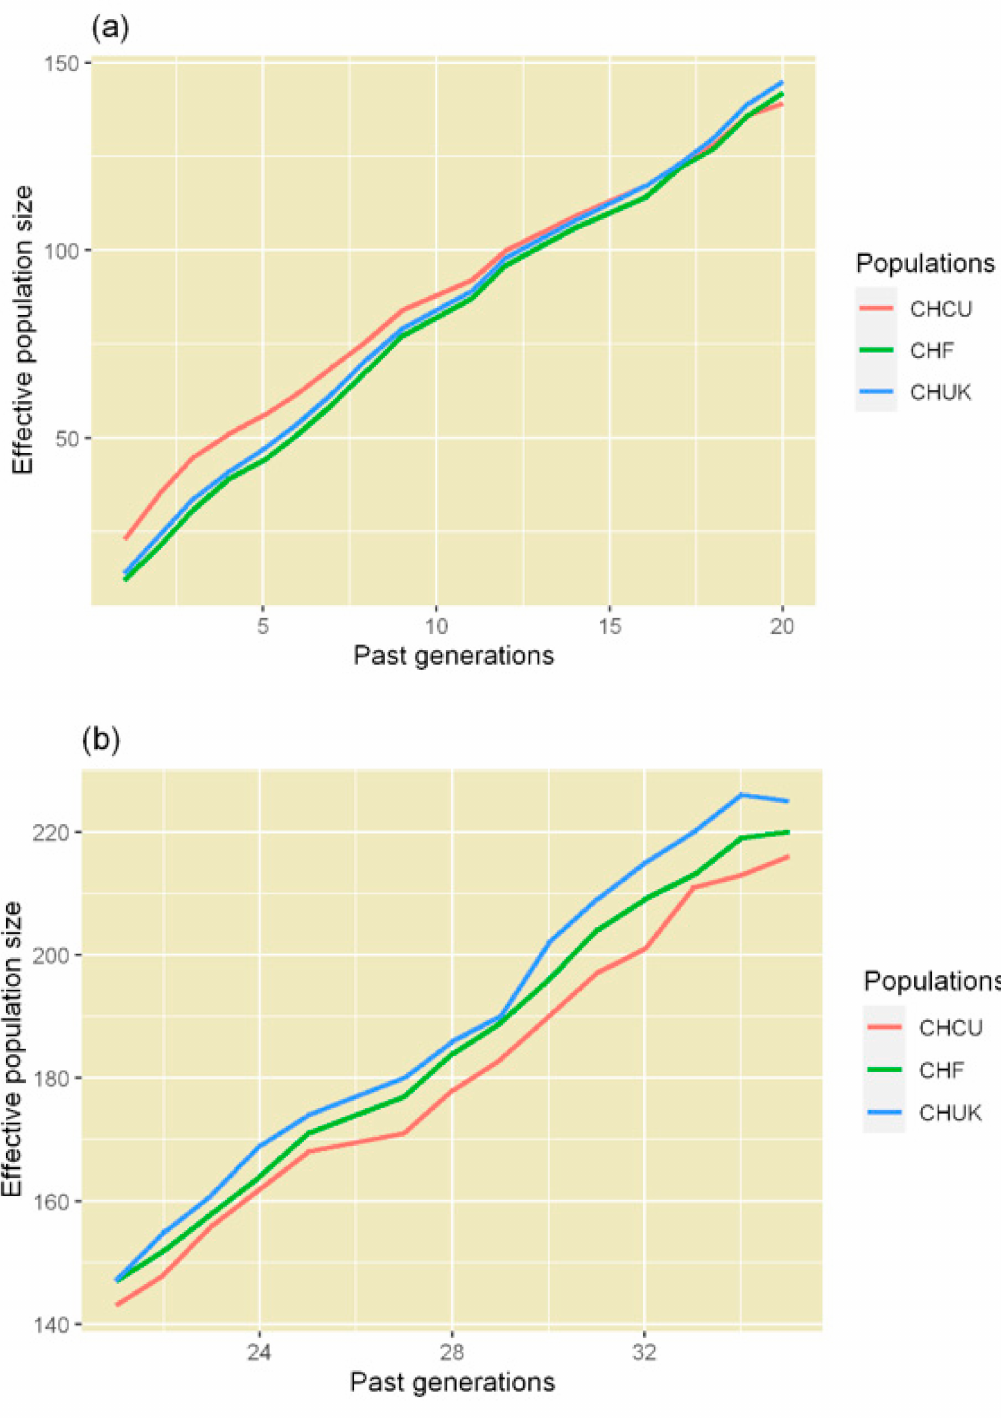
Figure 3. E ff ective size of three populations of the Charolais breed: ( a ) approximately 20 generations and ( b ) from 21 to 35 generations. Blue line, Charolais de Cuba; red line, French Charolais; and yellow line, British Charolais. x -axis: past generations; y -axis: e ff ective population